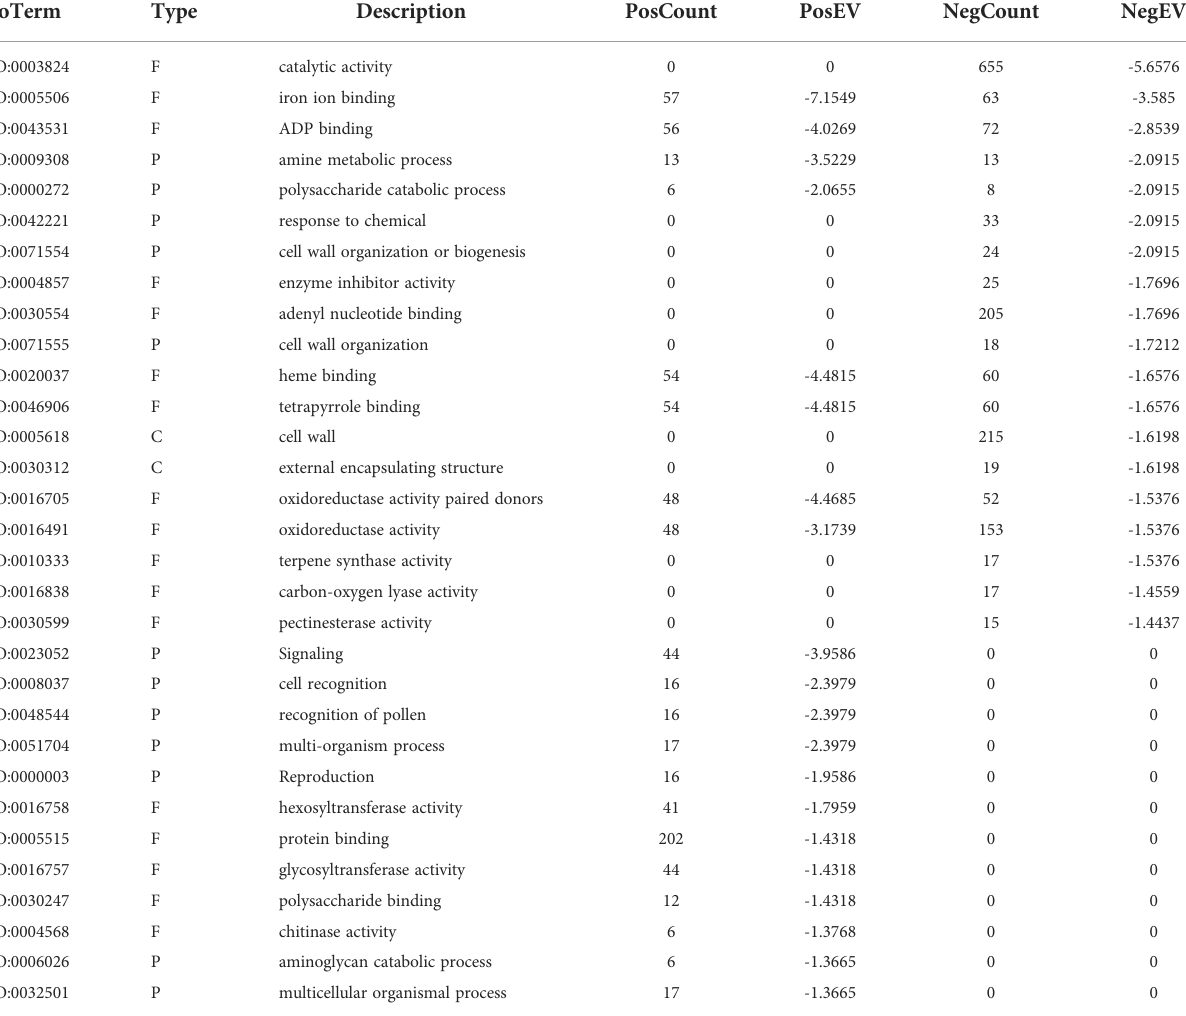
TABLE 2 Signi fi cant GO terms represented in the HLB infected fi nger lime vs HLB infected ‘ Valencia ’ comparison.